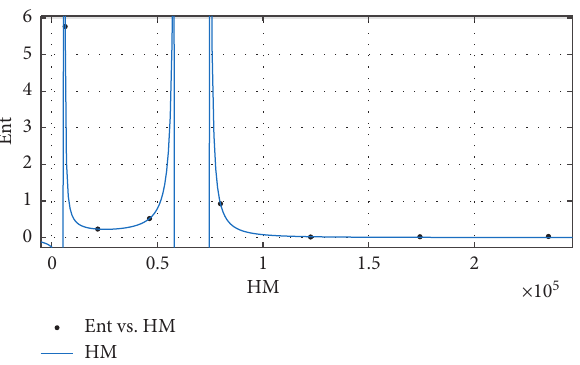
Figure 13: Entropy ( HM ) .